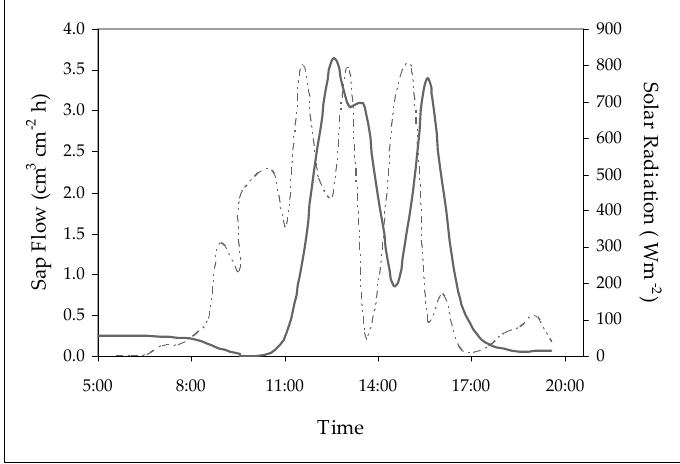
Figure 4. An example of a White spruce tree diurnal sap flow. Tree’s diameter at breast height was 18 cm. Day of the year: 232, in 2004. Dashed line is R s and the solid line is J i .